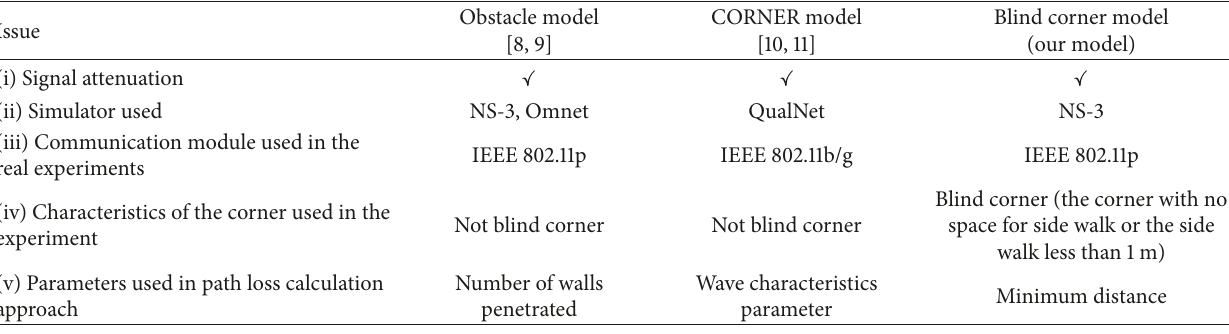
Table 1: Comparison of the models.